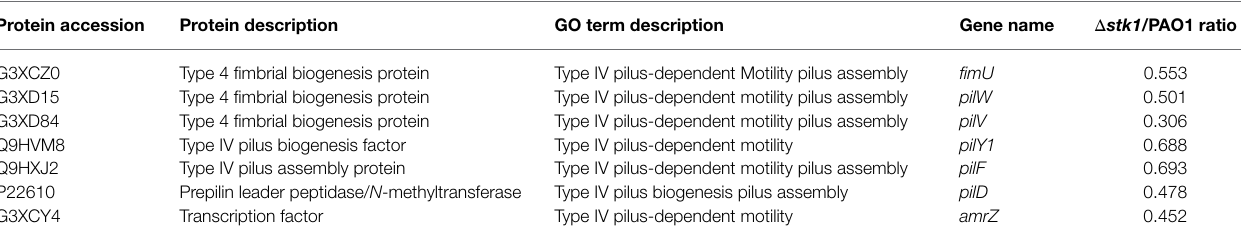
TABLE 2 | The downregulated type IV pilus-related proteins in the Δ stk1 strain compared with the PAO1 strain. Protein accession